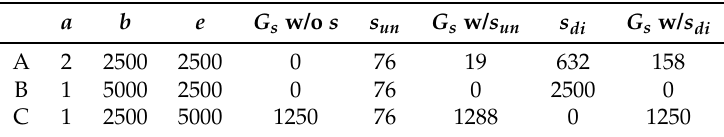
Table 1. Solar PV capacity G s under three subsidy policies: no subsidy ( w / os ), uniform subsidy ( eq ), differential subsidy ( di )